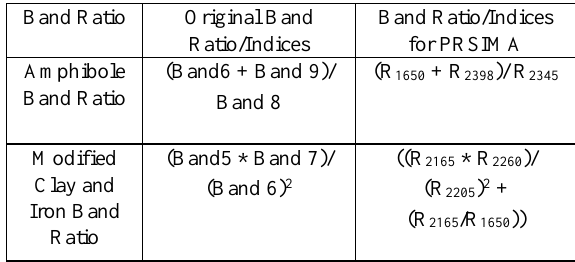
Table 2. Narrowband Ratio for PRISMA